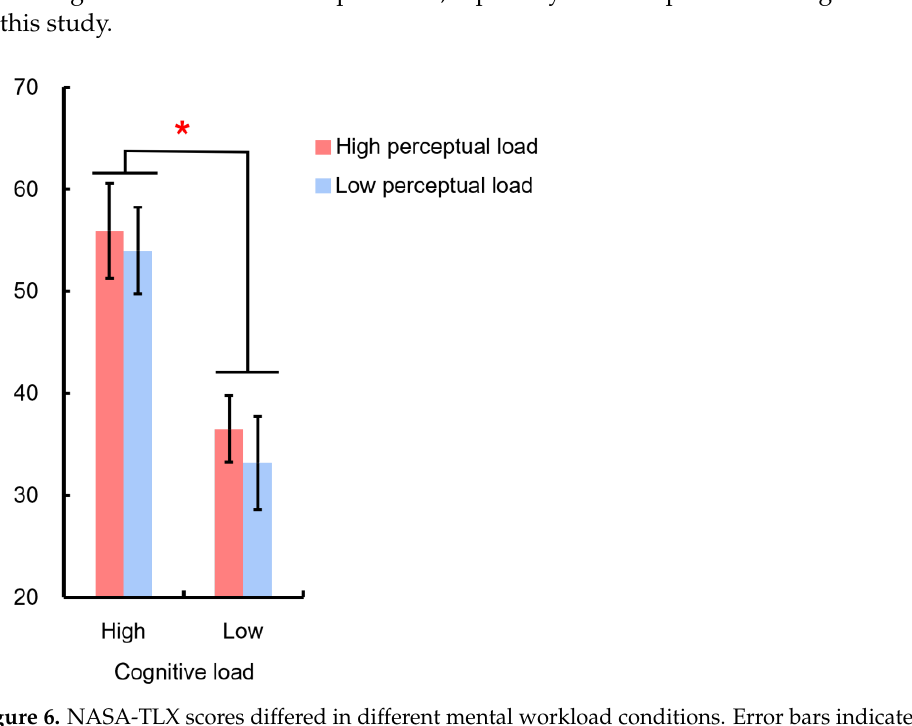
Figure 6. NASA-TLX scores differed in different mental workload conditions. Error bars indicate one standard error from the mean. * p < 0.05.